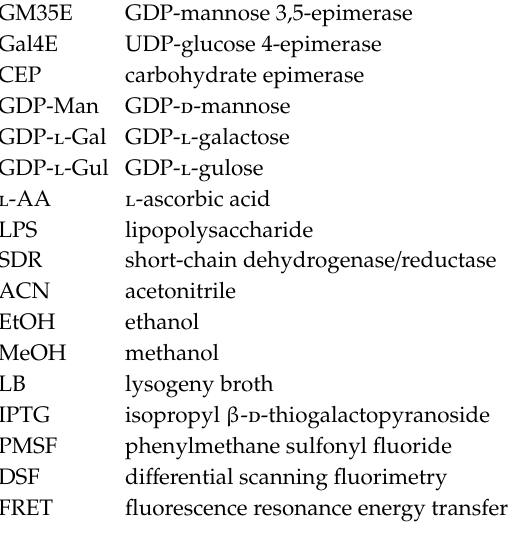
Figure S1: SDS-PAGE of Mf GM35E purification; Figure S2: Melting curves obtained through DSF; Figure S3: Genomic context of GM35E in Methylacidiphilum fumariolicum strain